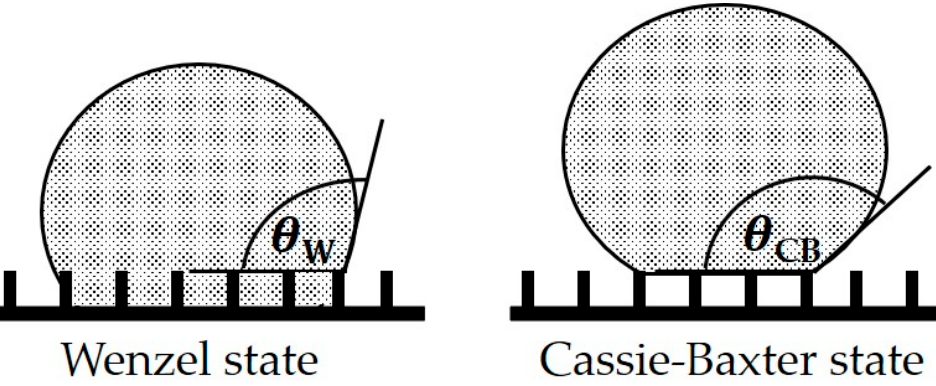
Figure 1. Different contact angle cases for rough homogeneous surfaces: Wenzel state and Cassie- Baxter state.